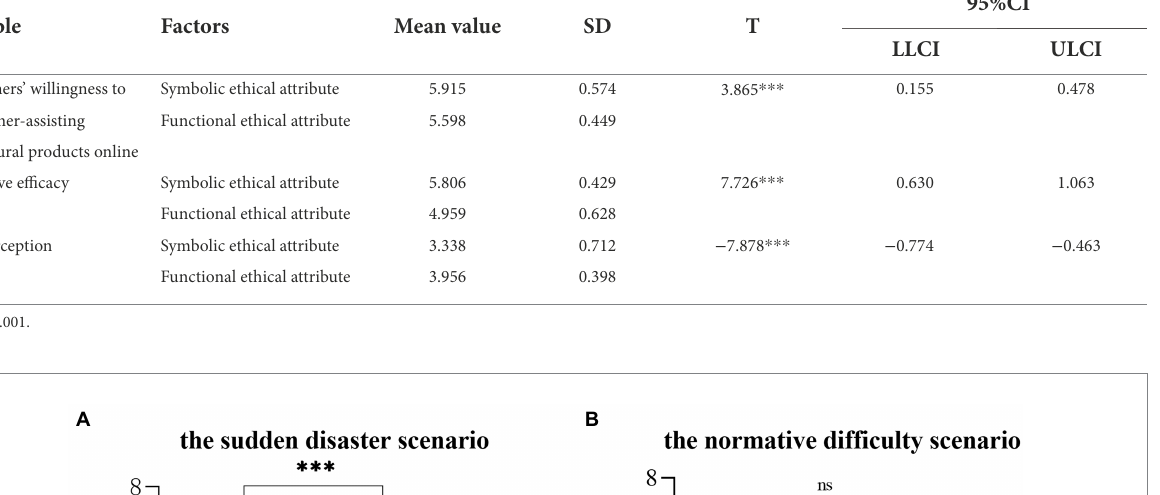
TABLE 6 Results of independent samples t